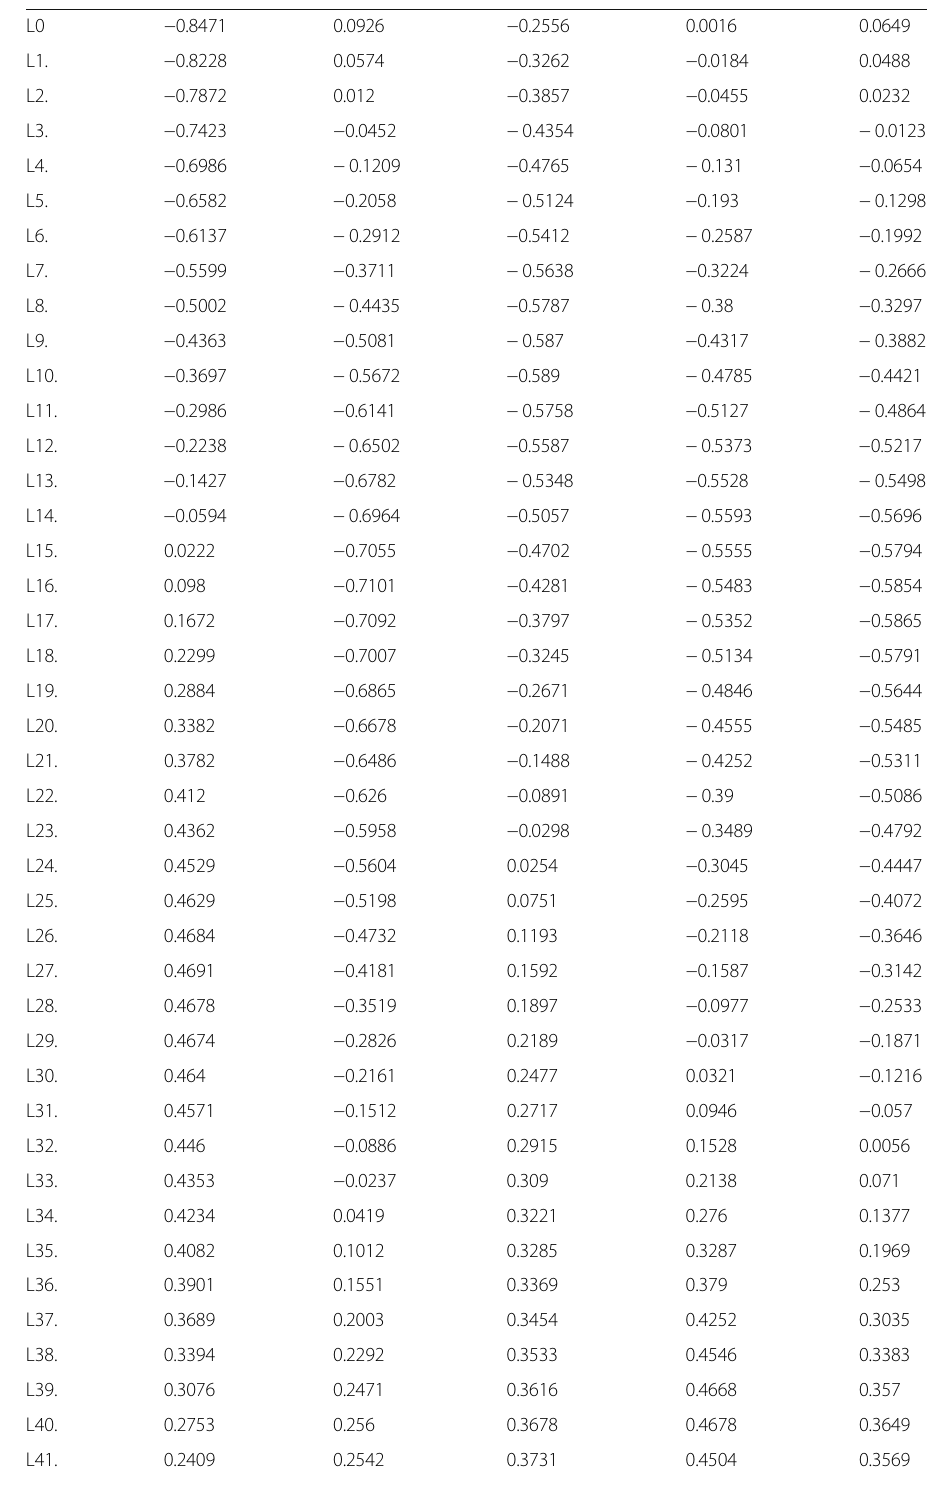
Table 1 Correlation between Cyclical Components of GREA and Lags of the Cyclical